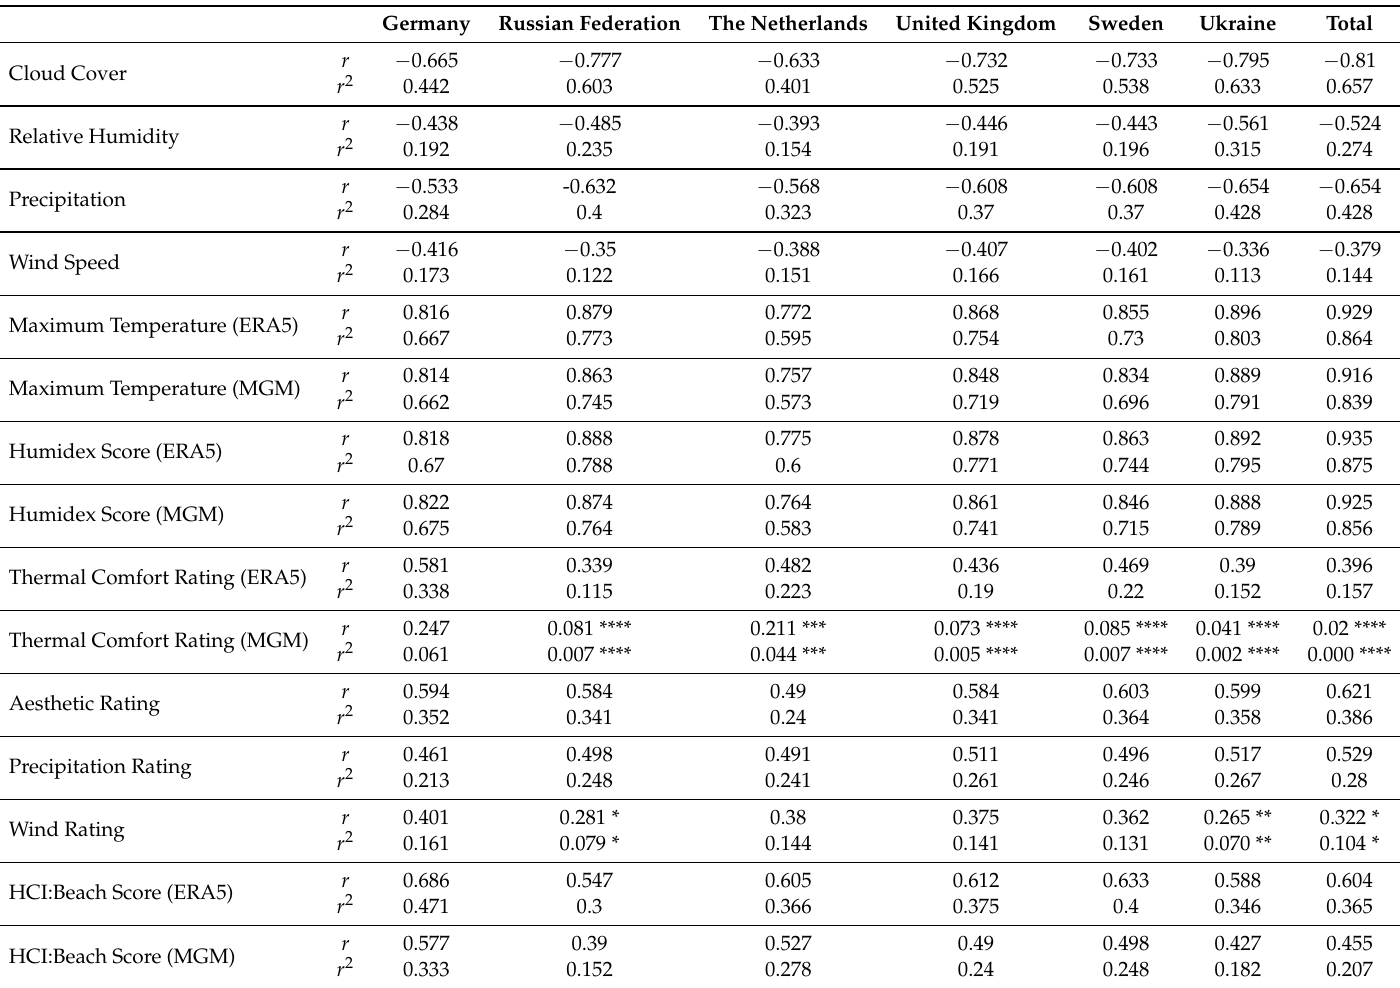
Table 3. HCI:Beach Scores and Their Components as Estimators of Monthly Arrivals to Antalya (Turkey) from the Top Source Markets